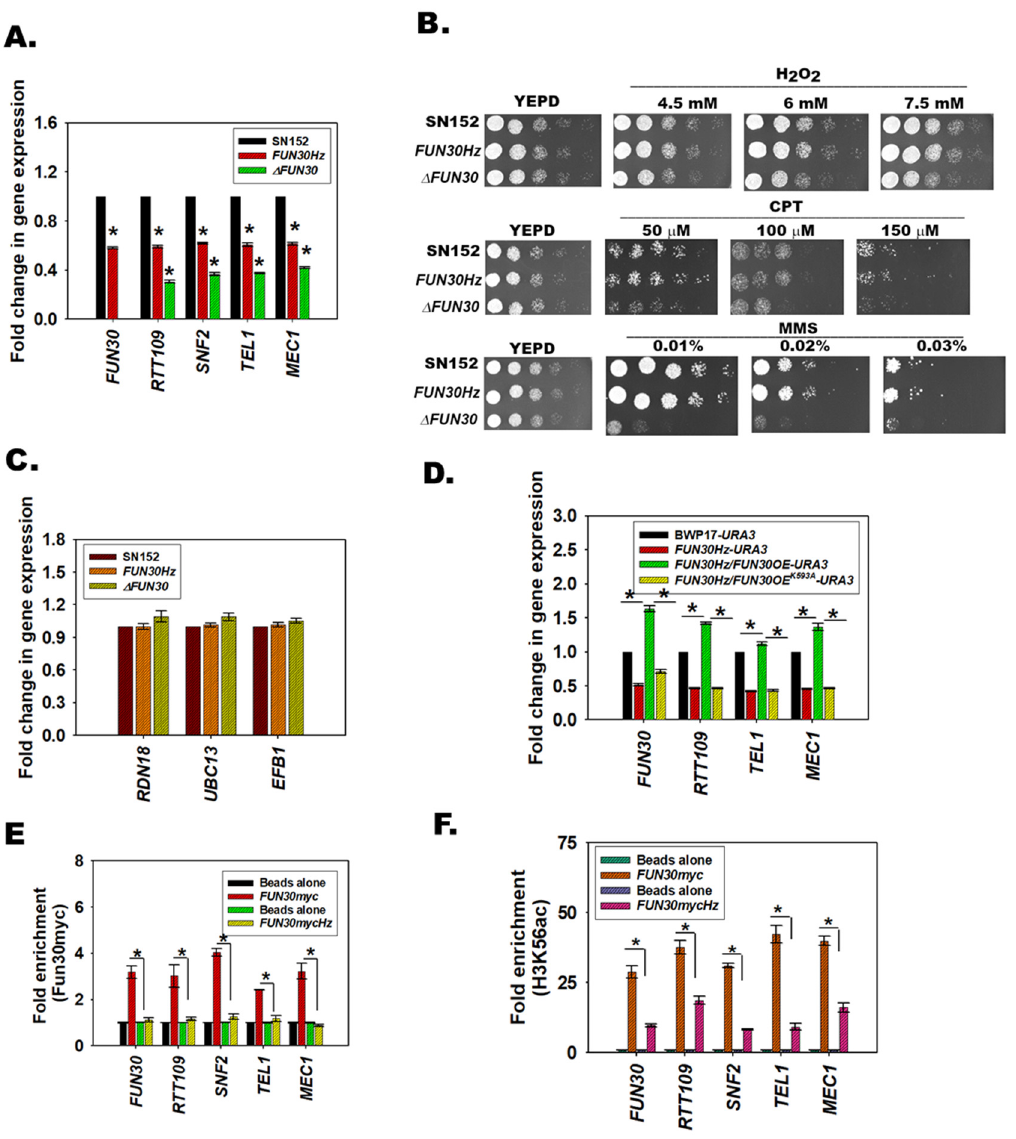
Figure 3. Fun30 regulates the expression of RTT109 , SNF2 , TEL1 , and MEC1 in C. albicans . ( A ). Expression of FUN30 , RTT109 , SNF2 , TEL1 , and MEC1 in FUN30Hz and ∆ FUN30 was